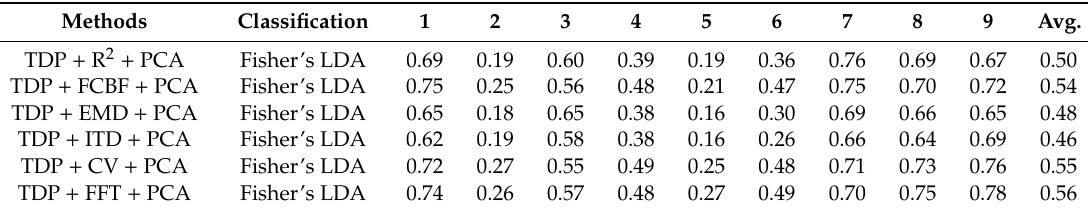
Table 3. Comparison of standard feature extraction